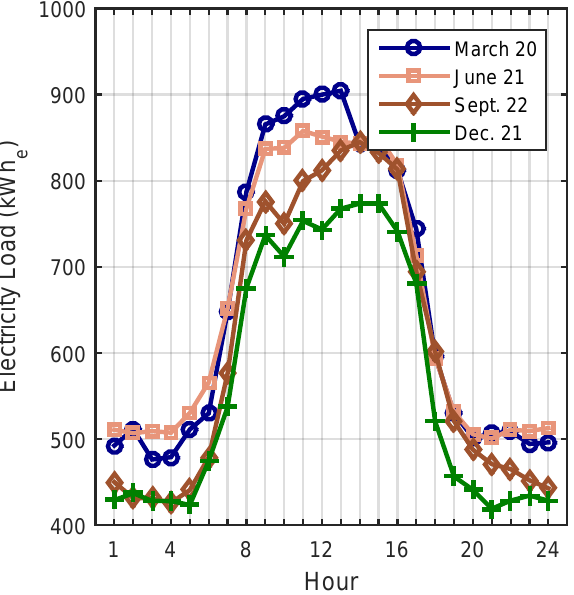
Figure 2. Average electricity load of the districts of